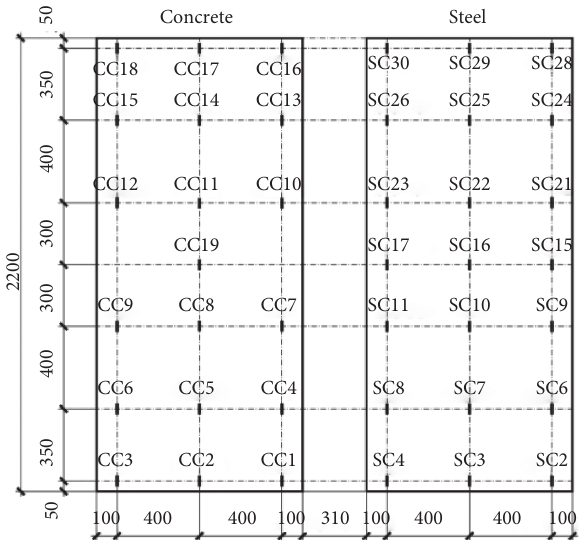
Figure 23: Arrangement of strain measuring points for jointless specimens in compressive experiment.